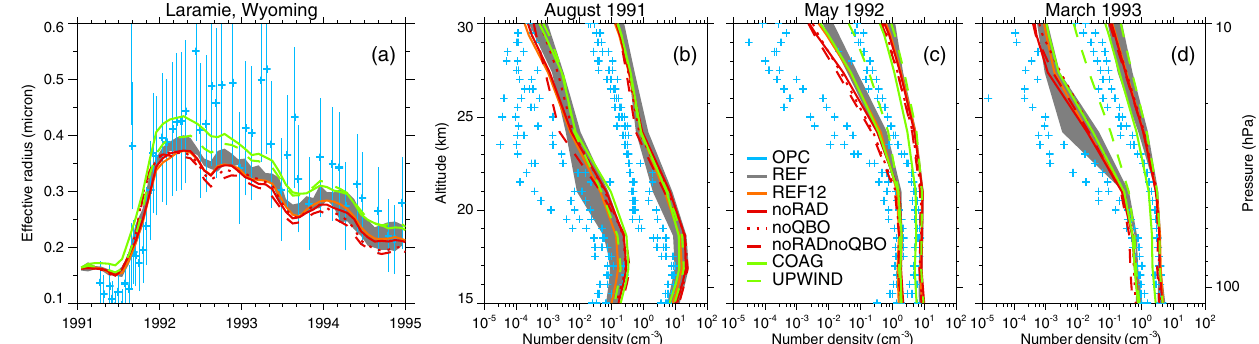
Figure 2. Comparison of in situ measurements of particle size (at Laramie, Wyoming; Deshler, 2008) with SOCOL-AER simulations. (a) Stratospheric effective particle radius averaged for 14–30km of altitude. Thin blue whiskers reflect measurement uncertainty (taken from Kleinschmitt et al., 2017). (b–d) Profiles of cumulative number densities for two size channels with radii R > 0 . 15µm (right group of curves) and R > 0 . 5µm (left group of curves) in August 1991, May 1992, and March 1993, respectively. SOCOL-AER results are monthly means, while OPC data are discrete measurements within chosen